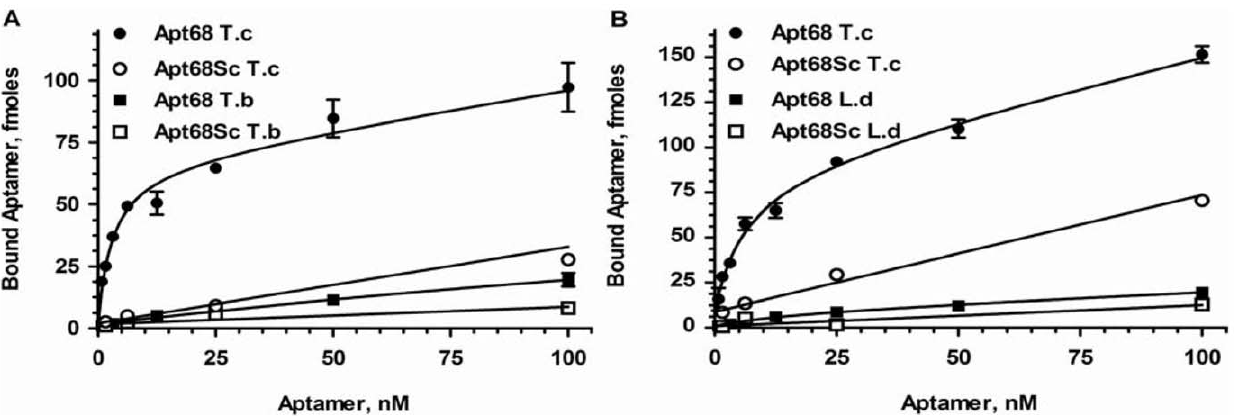
Figure 4. Binding of Apt68 is specific to T.cruzi and not to other related parasites, T.brucei and L.donovani. 32 P-GTP labeled Apt68 was used in binding assays as in Figure 2. Apt68 is highly specific for the mammalian stage of the parasite and showed dose depended saturable binding compared to T. brucei blood stream form (A). Apt68 also did not interact significantly with L. donovani promastigotes (B). Each data point represents triplicate values and the error bars represent the standard deviation. As Apt68 did not show significant binding to the L. donovani and T. brucei parasites, above that of the scrambled aptamer, Bmax and Kd could not be calculated.